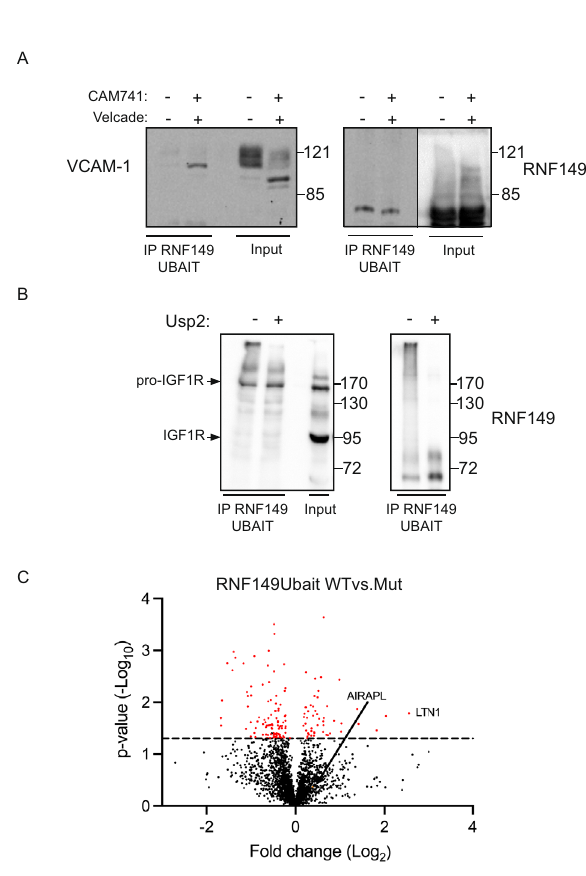
Fig. 2 pEQC substrate association with RNF149. A 293 cells expressing RNF149UBAIT and the pEQC substrate VCAM-1 were treated as indicated with velcade and CAM741. Cell lysates were adjusted to RIPA buffer and a Flag IP was applied followed by extensive RIPA buffer washes. IP content was evaluated towards RNF149 and VCAM-1 content by Flag and HA immunoblots respectively. Total content prior to IP is indicated as